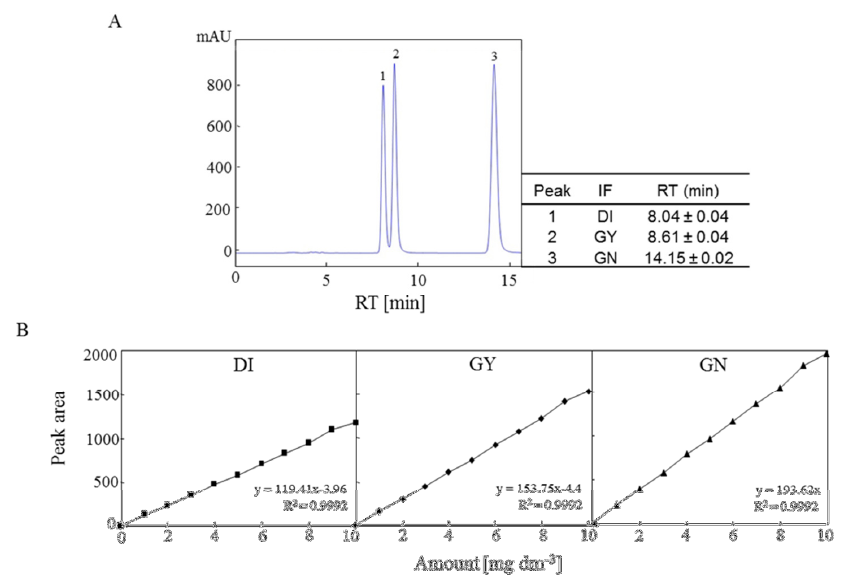
Fig. 2. A typical chromatographic separation of aglycone IF standards; A. Representative HPLC chromatogram illustrating separation of aglycone IF standards; daidzein (DI), glycitein (GY) and genistein (GN). Each IF standard was evaluated by their peak area with corresponding retention time (min); B. Different concentration of each aglycone standard (0-10 mg dm -3 ) was evaluated. Standard calibration graphs displaying the linearity between chromatogram peak area and amount of each aglycone IF standard. The R2 values for the fitted lines displaying >0.99 indicates a good fit and gives confidence for reliable IF